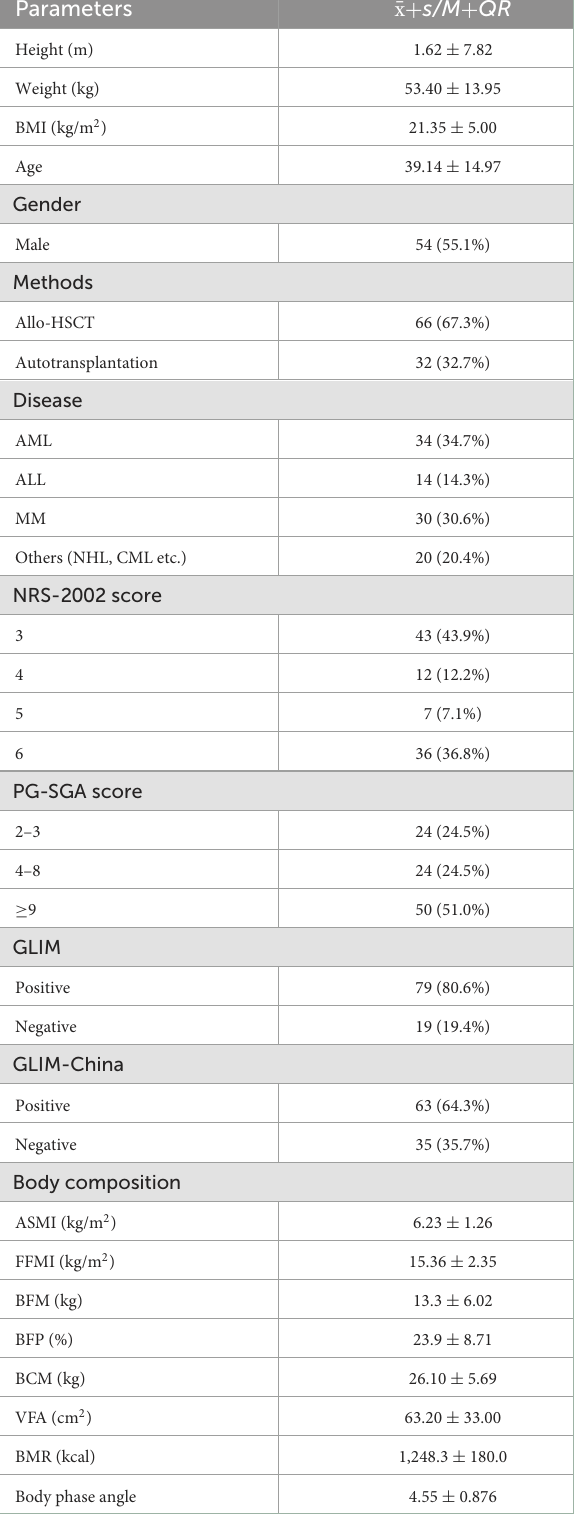
TABLE 1 Nutritional status and human body composition of patients with peri-HSCT. Parameters